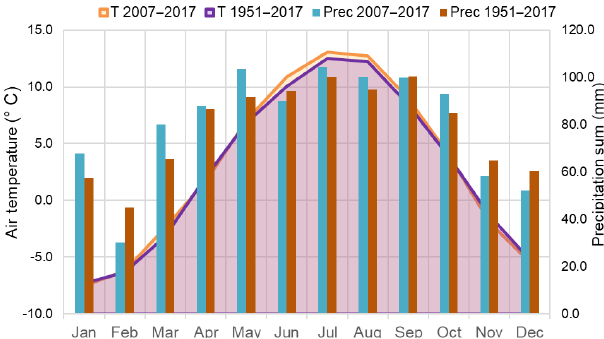
Figure 2. Monthly distribution of air temperature and precipitation for the period of the dataset (2007–2017) compared to the long-term period (1951–2017) at the all-year weather station Terskol nearest to the Djankuat research basin